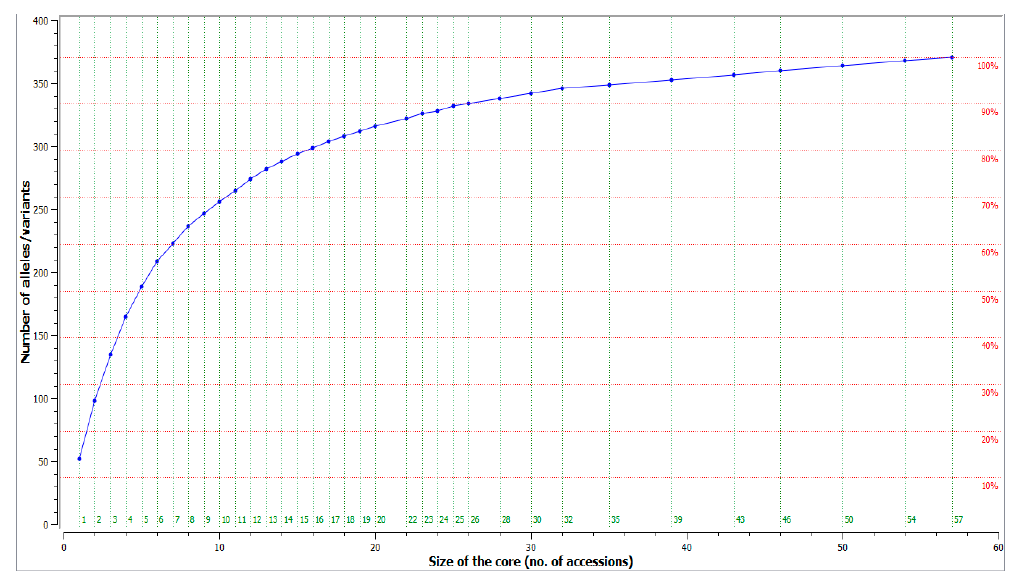
Figure 6. Genetic diversity as a function of the number of accessions included in the core collection.